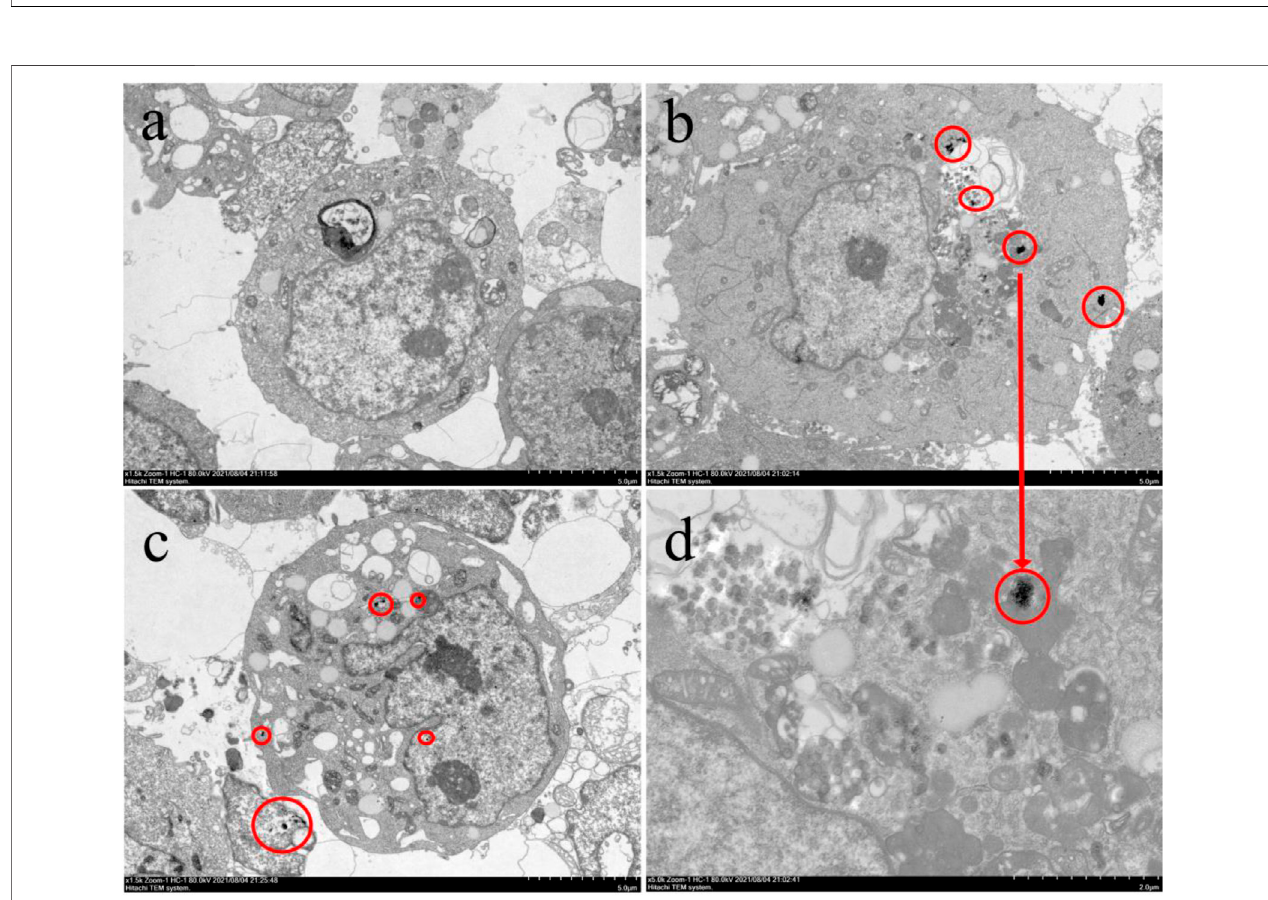
FIGURE5| TEMimageof (A) cellsofcontrol, (B) cellsofNPs75, (C) cellsofNPs75-Pb7.5,and (D) enlargementofNPs75.TheinnerNPsclustersarecircledinred.